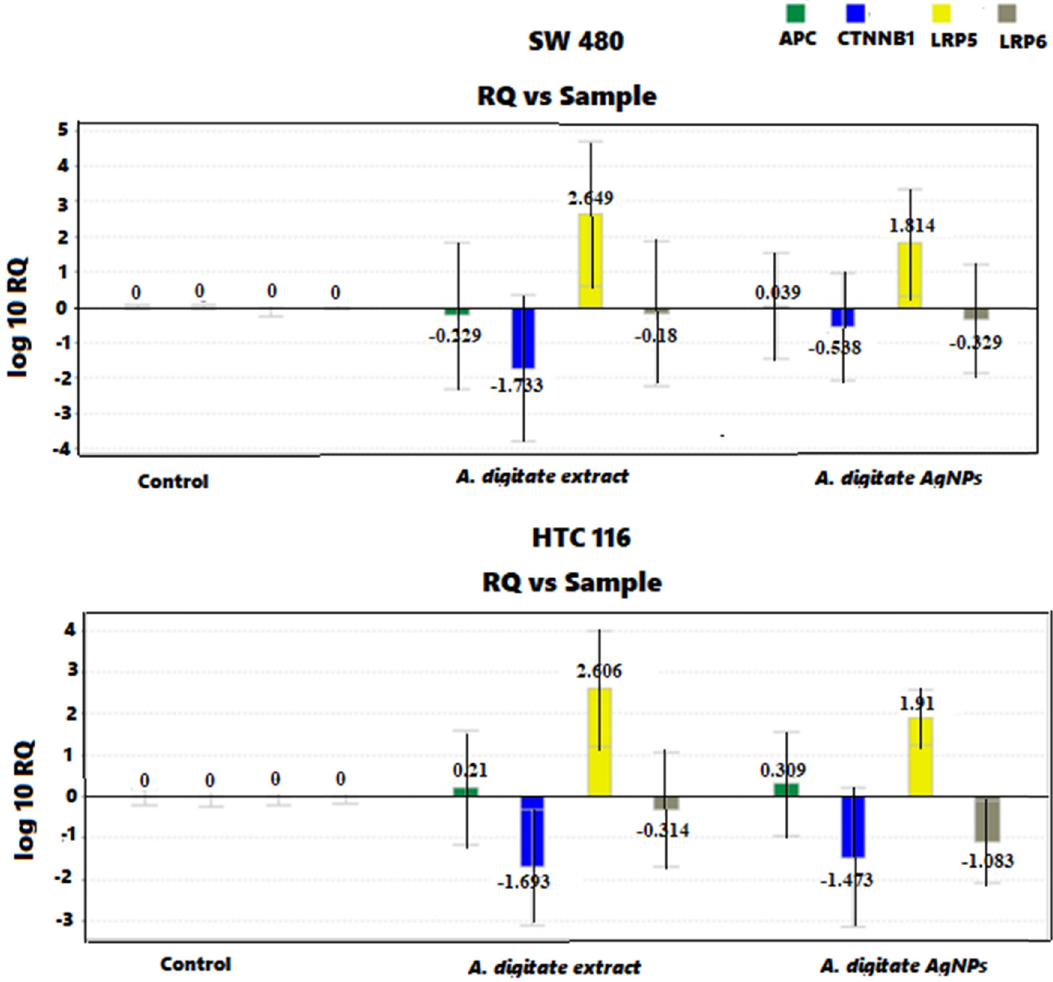
Figure 8: Gene expression fold change in SW480 and HTC116 cell lines treated with A. digitata extract and green - synthesized A. digitata